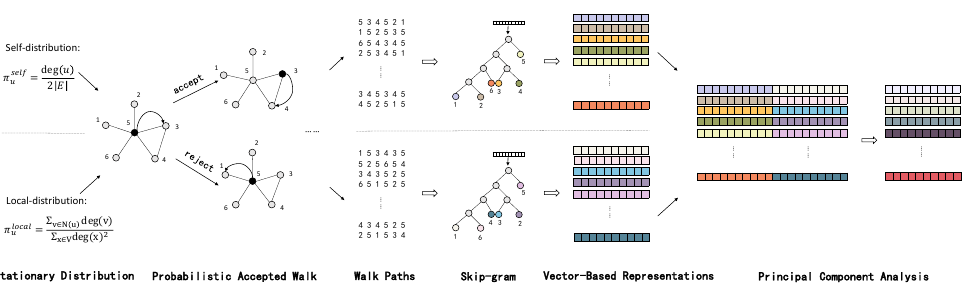
Figure 2. Framework Overview. We first propose two stationary distributions. According to each of the proposed stationary distributions, the PAW strategy starts with a random node (node 5) and then uniformly takes one of its neighbors (node 3) as a selected target. If the transfer is accepted, the walk will move to the neighbor (node 3 is sampled into paths). Otherwise, the walk will stay at the current position (node 5) and reselect a neighbor (node 1). The random walk continuously repeats the above process until the specified path length is reached. Next, we separately feed the paths into two skip-gram models to obtain vector-based representations. Finally, we utilize the principal component analysis algorithm to fuse two representational vectors of nodes into a unified space and obtain low-dimensional latent